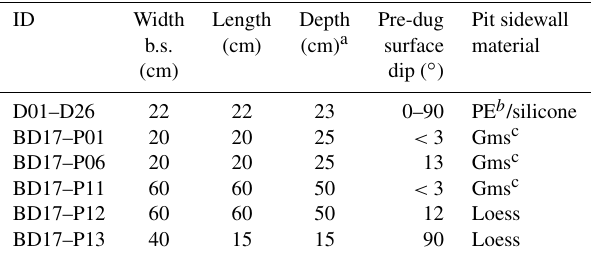
Table 1. Test pit designs used for the imaging testing